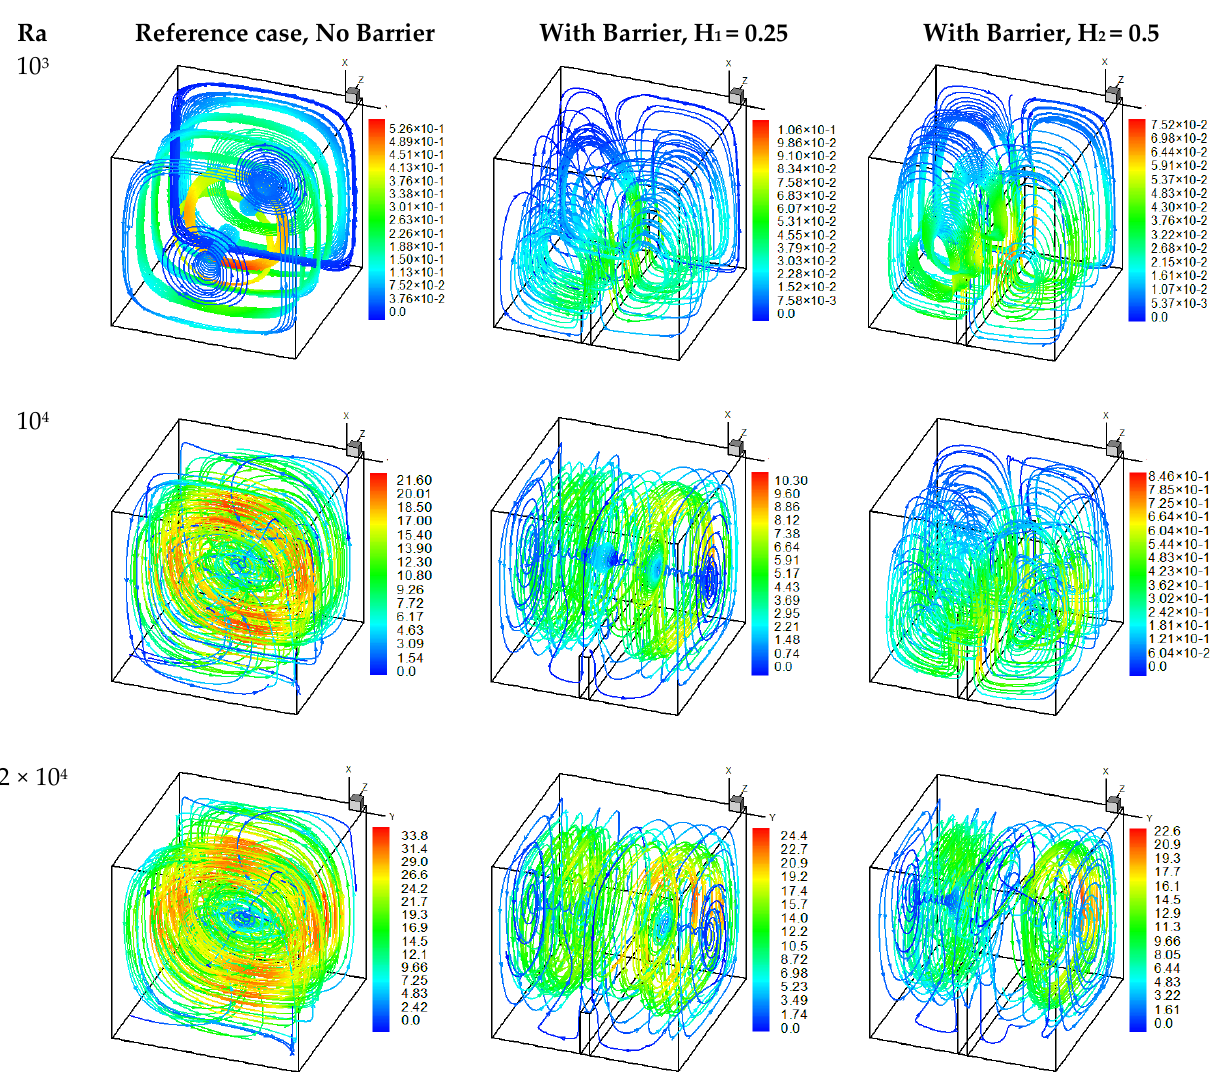
Figure 11. Particles’ trajectories of the fluid in the building for different Ra , effect of two barriers’ heights for N = 0.2. A modification of the flow structure is observed for barrier 1 (the barrier with a height equal to H 1 ) from Ra = 10 4 and for barrier 2 when Ra = 2 × 10 4 . In fact, the flow structure is